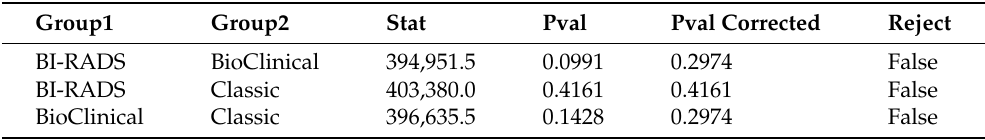
Table A3. Bonferonni-corrected Mann–Whitney U test results for section segmentation with auxil- iary data.